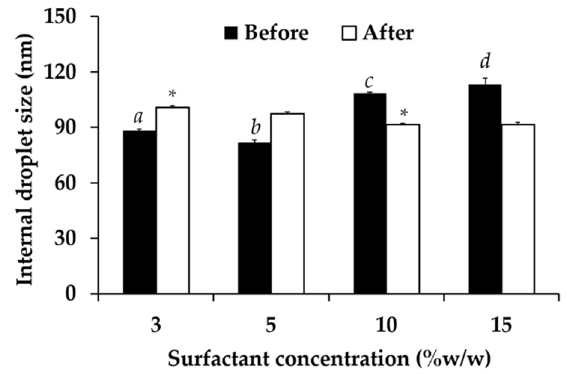
Figure 8. Internal droplet size of nanoemulsion generated using various amount of surfactant, 3, 5, 10, and 15% w / w , before and after 8 cycles of heating-cooling condition. The letters a, b, c, and d including 3, 5, 10, and 15% w/w , before and after 8 cycles of heating-cooling condition. The letters a, denoted significant di ff erence between formulations analyzed using post-hock Tukey ANOVA ( p < 0.05). b, c, and d denoted significant difference between formulations analyzed using post-hock Tukey Asterisk (*) denoted significant di ff erence between before and after the stability test analyzed using ANOVA ( p < 0.05). Asterisk (*) denoted significant difference between before and after the stability t -test ( p < 0.05). test analyzed using t-test ( p < 0.05).